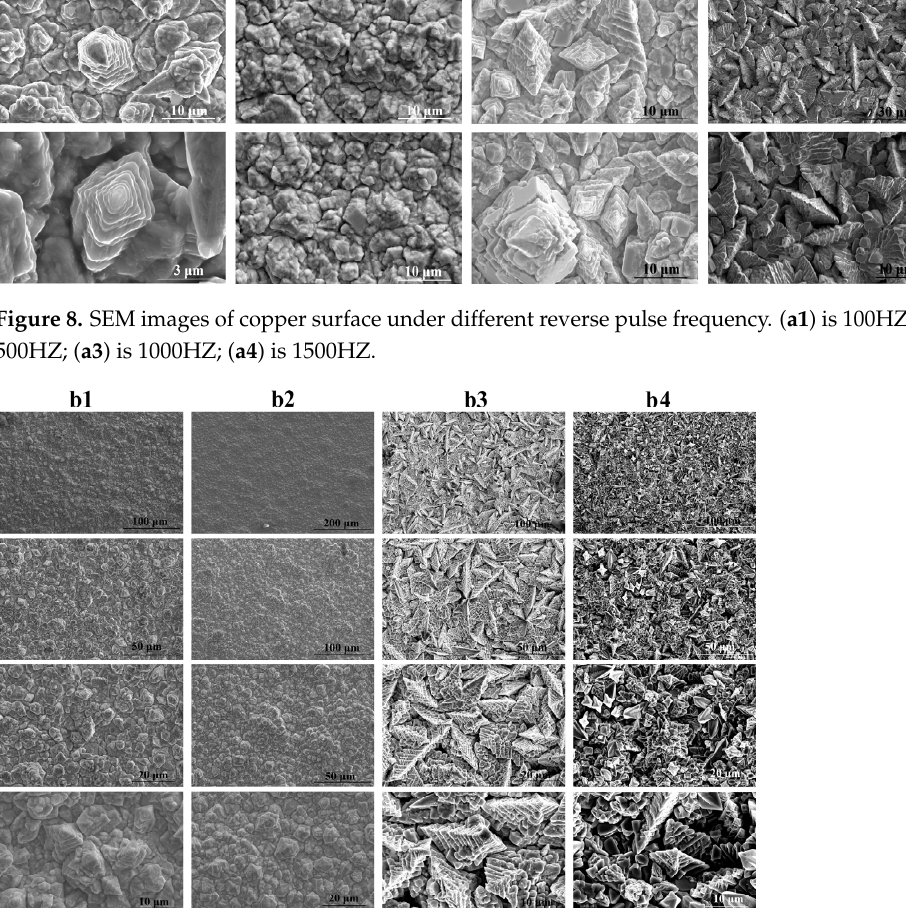
Figure 10. SEM images of copper surface under different reverse pulse current density. ( c1 ) is 0.1A/dm 2 ; ( c2 ) is 0.2A/dm 2 ; ( c3 ) is -0.4A/dm 2 ; ( c4 ) is 1A/dm 2 ; 4. Conclusions This work systematically investigated the effect of reverse pulses parameters in re- verse pulses plating route on copper uniformity in high aspect ratio through holes. The uniformity, copper texture, and surface morphologies of the copper plating were charac- terized via SEM, XRD, and EBSD. The reverse pulse frequency can be tailored in a wide range of 100~1000 Hz. The reverse current density and the reverse duty cycle are more sensitive parameters. To achieve the high uniformity of the through-hole plating, the re- verse current density was preferably 10% of the forward current density, and the reverse